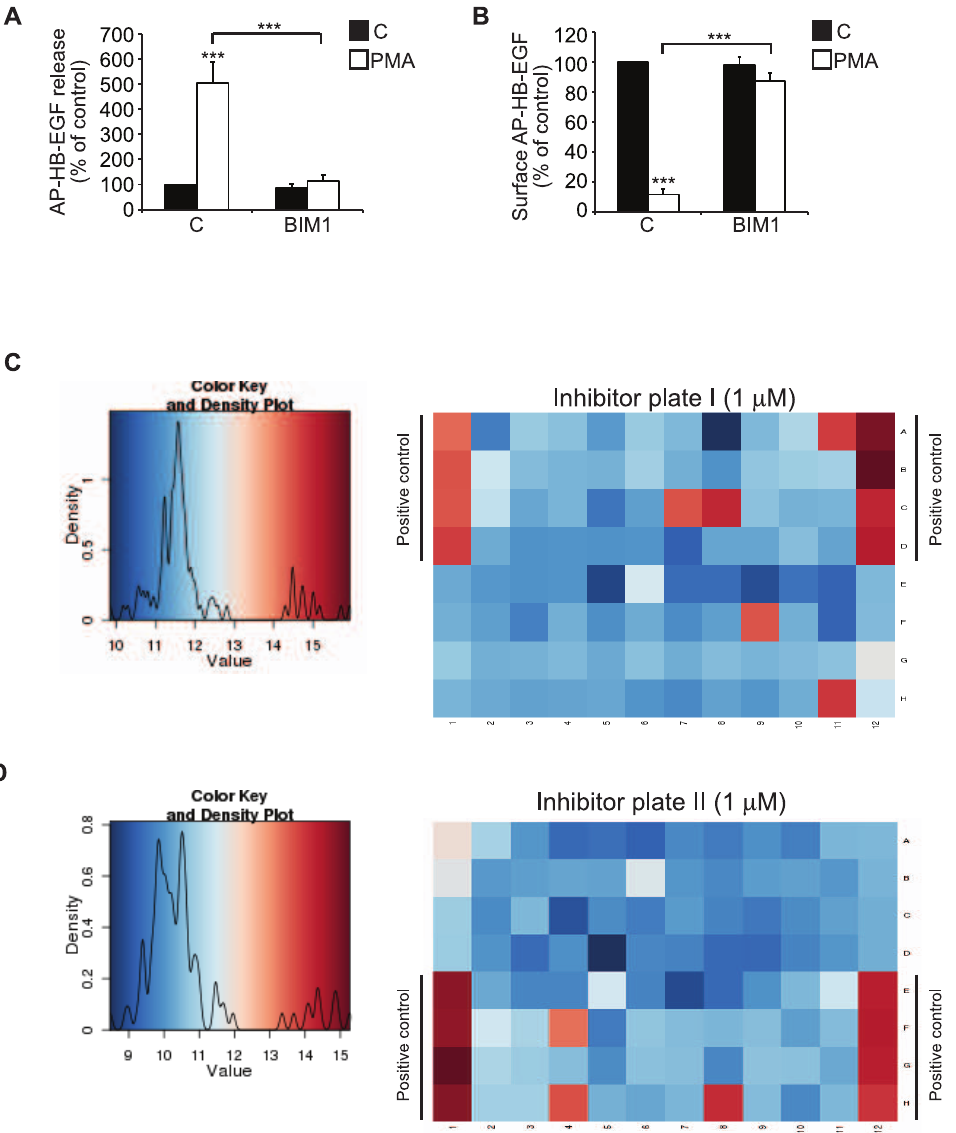
Figure 3. PMA-induced HB-EGF shedding is PKC-dependent. A ) AP-HB-EGF release measured as alkaline phosphatase activity (OD 405 nm) in conditioned media and B ) surface AP-HB-EGF measured as cell surface fluorescence intensity per cell (FLU/cell) in DMSO control-treated (C; black bars) and 30 min PMA-treated (PMA; white bars) AP-HB-EGF expressing HT1080 cells treated with the broad PKC inhibitor BIM1 (2 m M) or vehicle control. C, D ) Representative heat maps of cell surface fluorescence intensity per cell (FLU/cell) in PMA-treated (400 nM, 30 min) AP-HB-EGF expressing HT1080 cells treated with 1 m M of the InhibitorSelect TM 96-Well Protein Kinase Inhibitor Library I and II, respectively. Color key and density plots are shown to the right of the heat maps. All graphs show average values 6 standard error of the mean of at least three independent experiments each done in triplicate. *p , 0.05; **p , 0.01, ***p , 0.001 after one-way analysis of variance with Bonferroni’s post tests for multiple comparisons. Unless otherwise indicated, the comparison is relative to the respective